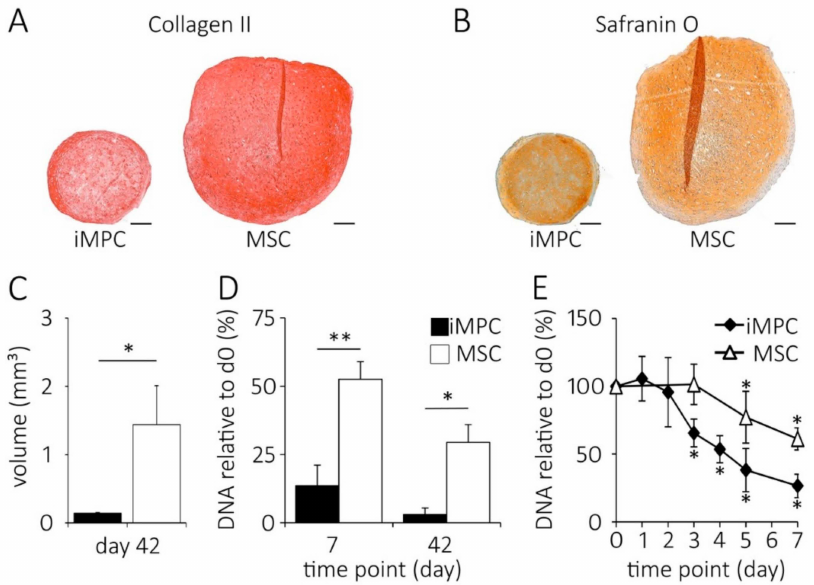
Figure 1. Size and DNA content of intermediate mesenchymal progenitor cells (iMPC)- versus mesenchymal stromal cells (MSC)-derived cartilage pellets. The 5 × 10 5 cells were subjected to chondrogenesis for the indicated time points and processed for histology and DNA quantification. ( A ) Collagen type II immunostaining and ( B ) Safranin O staining (representative staining of iMPC and MSC pellets, n = 4 independent donor populations per group, scale bar = 200 µ m). ( C )